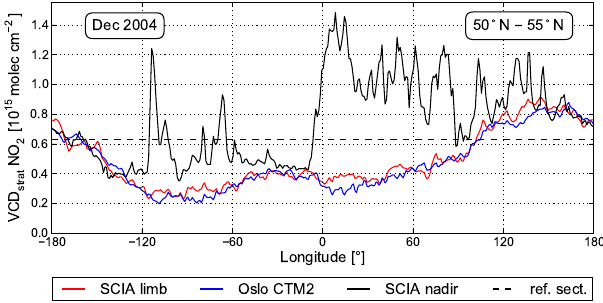
Fig. 12. Zonal variation of VCD 0 limb strat , VCD 0 mod strat , and VCD 0 nadir strat . The nadir measurements’ value over the reference sector is marked as dashed black line. Monthly mean values for December 2004, between 50 ◦ and 55 ◦ N.